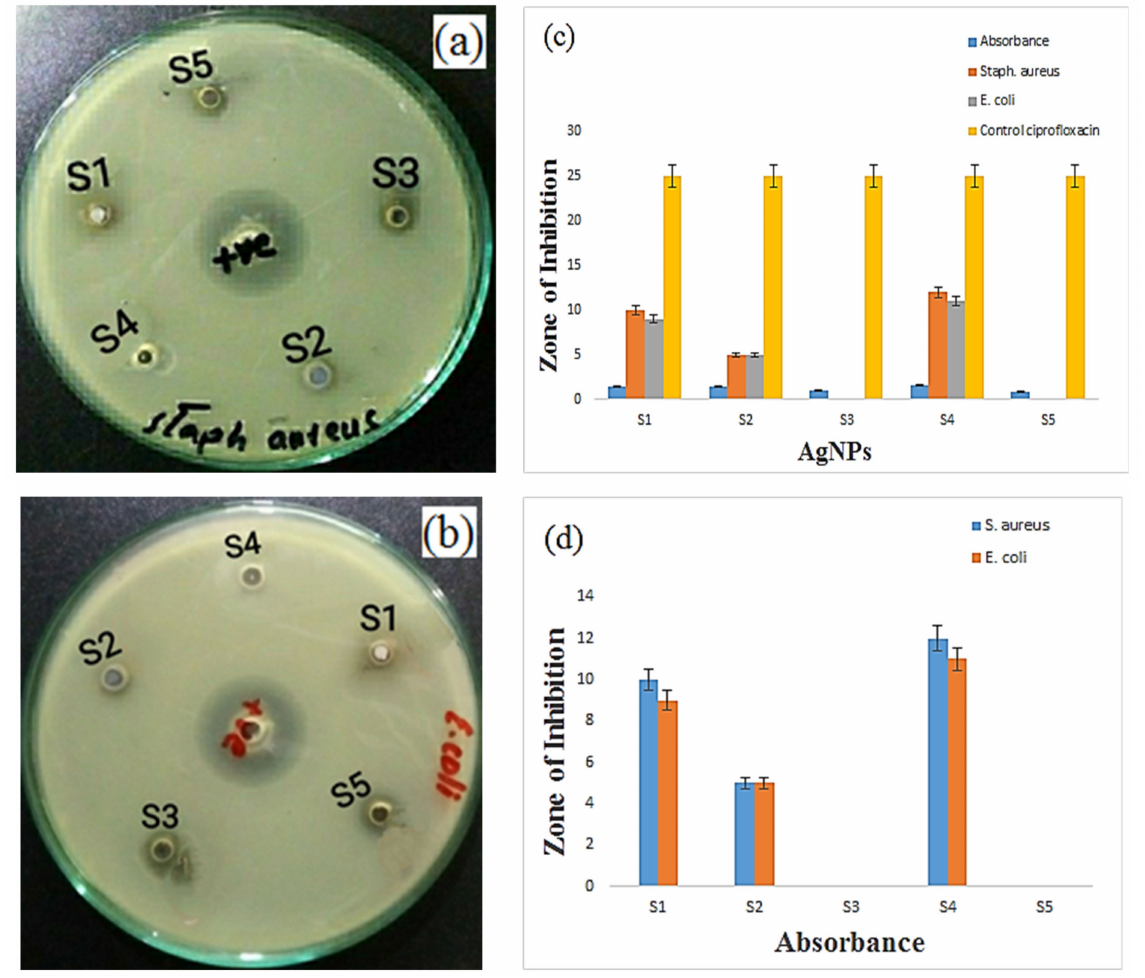
Figure 9. Photographs of inhibition zones of AgNPs with different stabilizing agents ( a ) Staph aureus and ( b ) E. coli and ( c ) comparative graph for zone of inhibition with absorbance and control; ( d ) representative graph of antibacterial activity. Table 6. Inhibitory effect of optimized AgNPs growth with different stabilizing